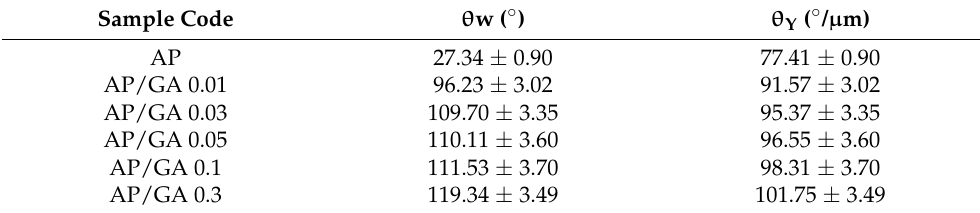
Figure 5. Comparison of contact angles θ w and θ Y of AP and AP/GA coatings at different GA content. Table 1. Wenzel and Young contact angles of AP and AP/GA